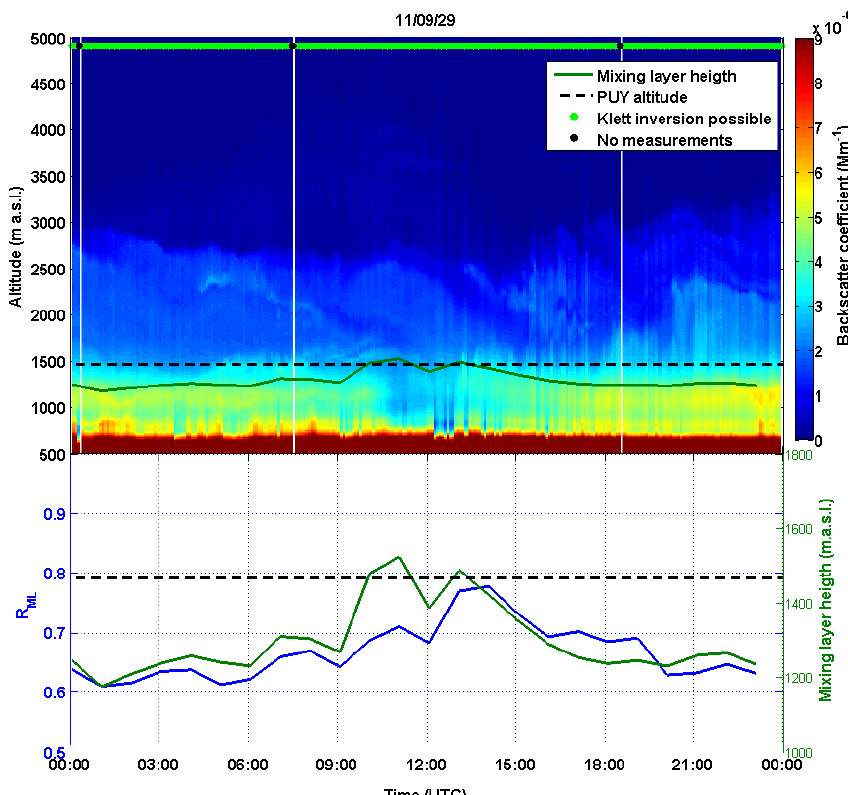
Figure 2. Top: aerosol backscatter time series (UTC) on 29 September 2011 from lidar measurements performed at CZ with a 5min reso- lution. Green points at the top of the figure indicate measurements with possible inversion and black points indicate no lidar measurements. Black dashed lines represent the Puy de Dôme top. Bottom: mixing layer height (green line) from WCT algorithm and mixing layer contri- bution ( R ML ) (blue line).